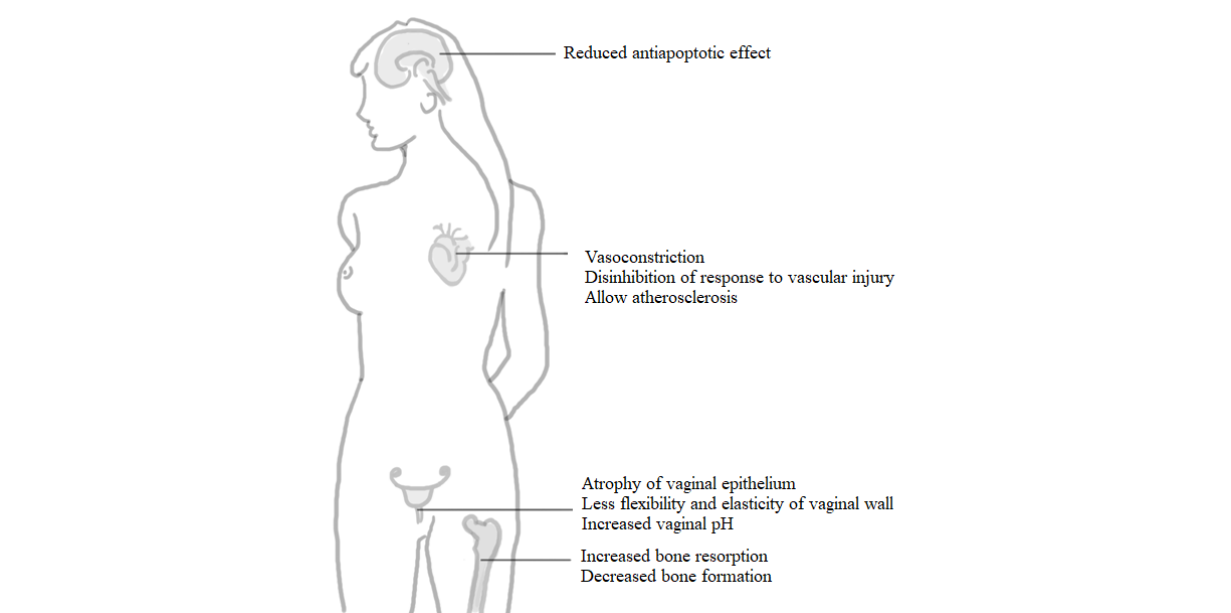
Figure 1. Overview of the effects of reduced estrogen levels on various organ